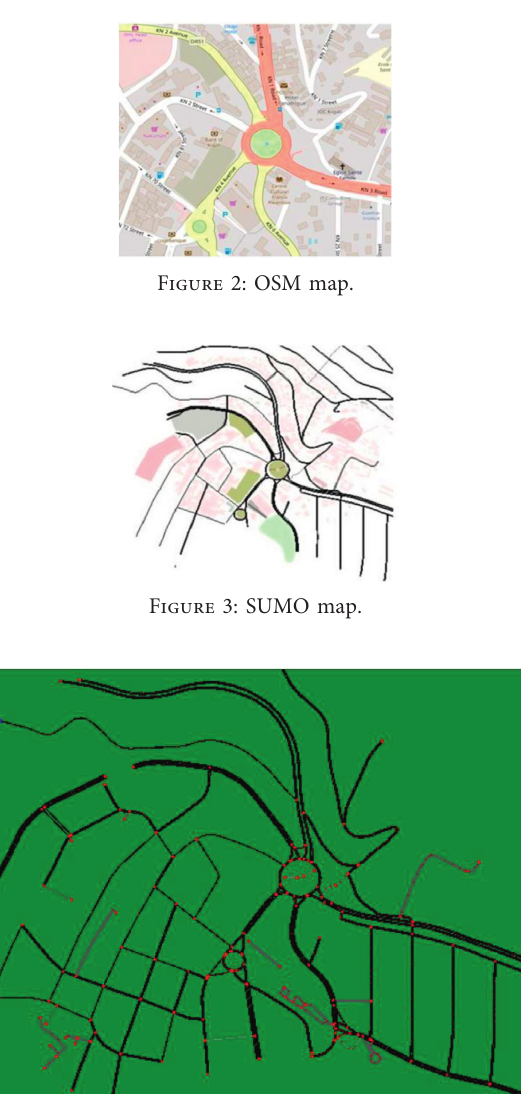
Figure 4: Main road intersections.